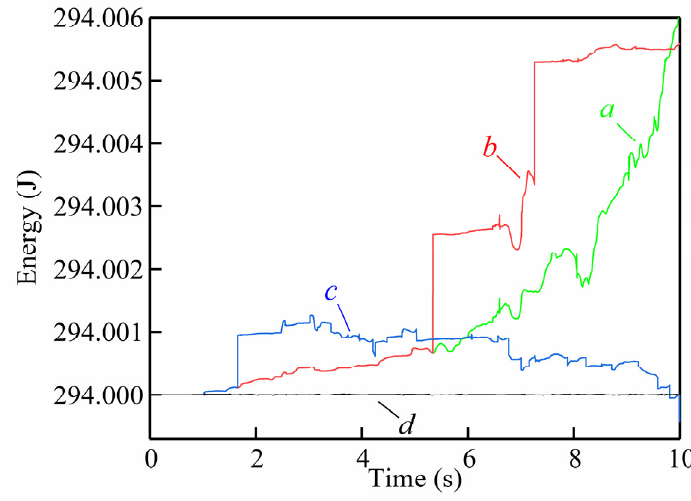
Figure 11. Variation of the mechanical energy for the multibody system with closed loops.